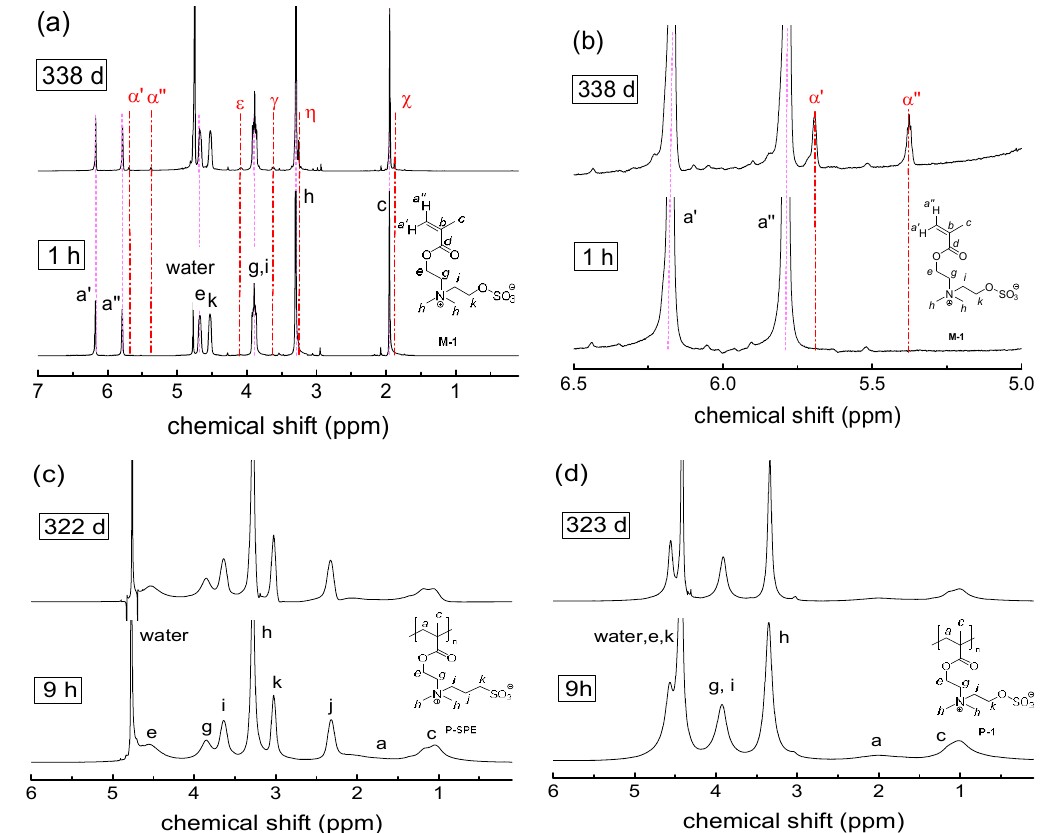
Figure 4. Evolution of the 1 H-NMR spectra over time illustrating the degradation behavior in phosphate buffered saline (PBS) in D 2 O (pH = 7.4) at room temperature for: ( a ) M-1 ; ( b ) Inset M-1 , ( c ) P-SPE ; ( d ) P-1 . Signal attributions of the starting compounds are labeled by roman letters, signal attributions of the degradation product by corresponding Greek letters (α, β, χ, δ, ε, φ, γ, η, ι, ϕ, and κ corresponding to a, b, c, d, e, f, g, h, i, j, and k, respectively). Broken vertical lines are meant as guide to the eye.